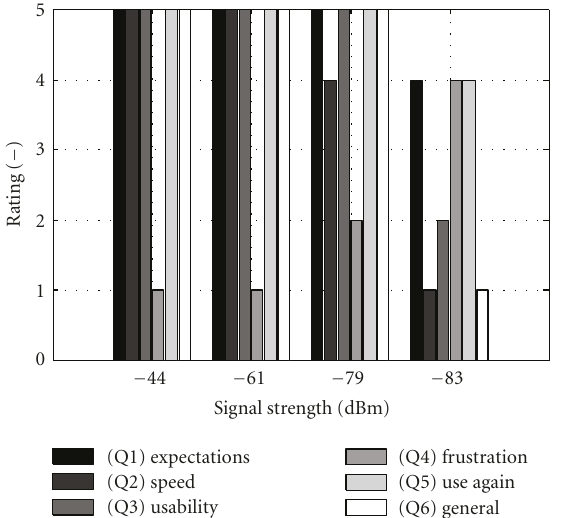
Figure 4: Ratings of the questionnaire (Q1, Q2, Q3, Q4, Q5, Q6) as a function of the signal strength for user 10.